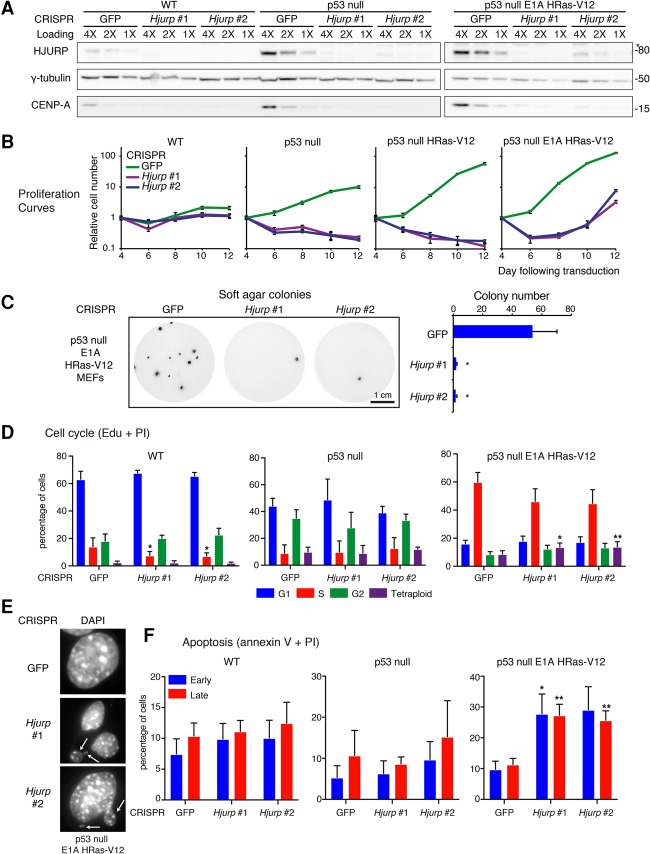
Transformed cells require HJURP for growth and survival. (A) Western blot of HJURP and CENP-A levels in wild-type, p53-null, or p53-null E1A and HRas-V12 transformed MEFs 6 d after transduction with CRISPR lentiviral particles against GFP (control) or two sgRNA constructs targeting Hjurp (Hjurp #1 and Hjurp #2) following puromycin selection. γ-Tubulin is used as a loading control. An asterisk marks a nonspecific band detected with the HJURP antibody. A twofold dilution series of each extract is represented by 4X, 2X, and 1X. Molecular weight protein markers are indicated at the right. (B) Proliferation assays in MEFs of the indicated genotypes following CRISPR-mediated depletion of Hjurp. MEFs (3 × 104) were seeded in triplicate in 1 mL of growth medium on 24-well plates 4 d after lentiviral transduction of CRISPR constructs. Hjurp CRISPR-resistant clones begin to emerge in E1A/HRas-V12 transformed p53-null MEFs 12 d after transduction. Results represent mean cell number ± SEM of triplicates relative to day 1 of the experiment and are shown in log scale. (C) Soft agar assay of p53-null E1A HRas-V12 transformed MEFs transduced with control (GFP) or Hjurp CRISPR constructs. We stained colonies with Sytox Green 4 wk after cell seeding. Bars represent quantification of visible colony numbers ± SEM. n = 3. P < 0.05, t-test. (D) Quantification of cell cycle analysis by flow cytometry (Edu/PI staining) in wild-type, p53-null, or p53-null E1A HRas-V12 transformed MEFs transduced with CRISPR constructs. Mean percentages of cells ± SEM for G1, S, G2/M, and tetraploid/aneuploid (>4N) populations (n = 3) are shown. Statistical significance is shown where relevant. (*) P < 0.05; (**) P < 0.005, t-test. See also Supplemental Figure S4D for corresponding flow cytometry plots. (E) Immunofluorescence images of p53-null E1A HRas-V12 transformed MEFs at day 6 after transduction with CRISPR constructs following puromycin selection. We stained nuclei with DAPI. See also Supplemental Figure S4F for full images. Individual magnified nuclei are shown. Micronuclei are highlighted by arrows. (F) Quantification of apoptosis by flow cytometry (Annexin V/PI staining) in wild-type, p53-null, or p53-null E1A HRas-V12 transformed MEFs transduced with CRISPR constructs. Mean percentages of cells ± SEM in early or late apoptosis are shown. Statistical significance is shown where relevant. (*) P < 0.05; (**) P < 0.005, t-test. See also Supplemental Figure S4E for corresponding flow cytometry plots.